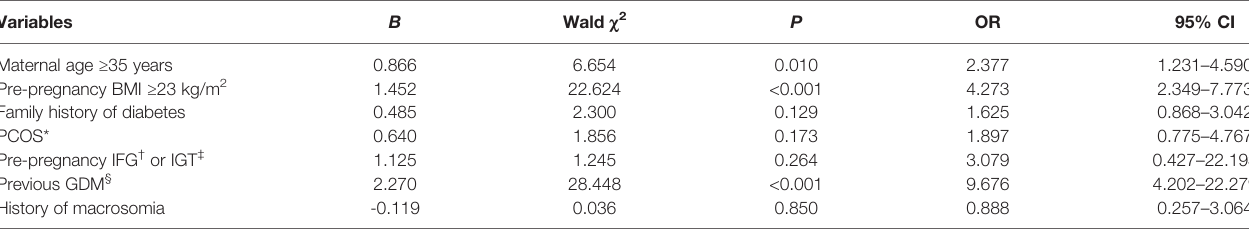
TABLE 3 | Multivariate logistic regression analysis of factors in fl uencing HIP diagnosis in early pregnancy.